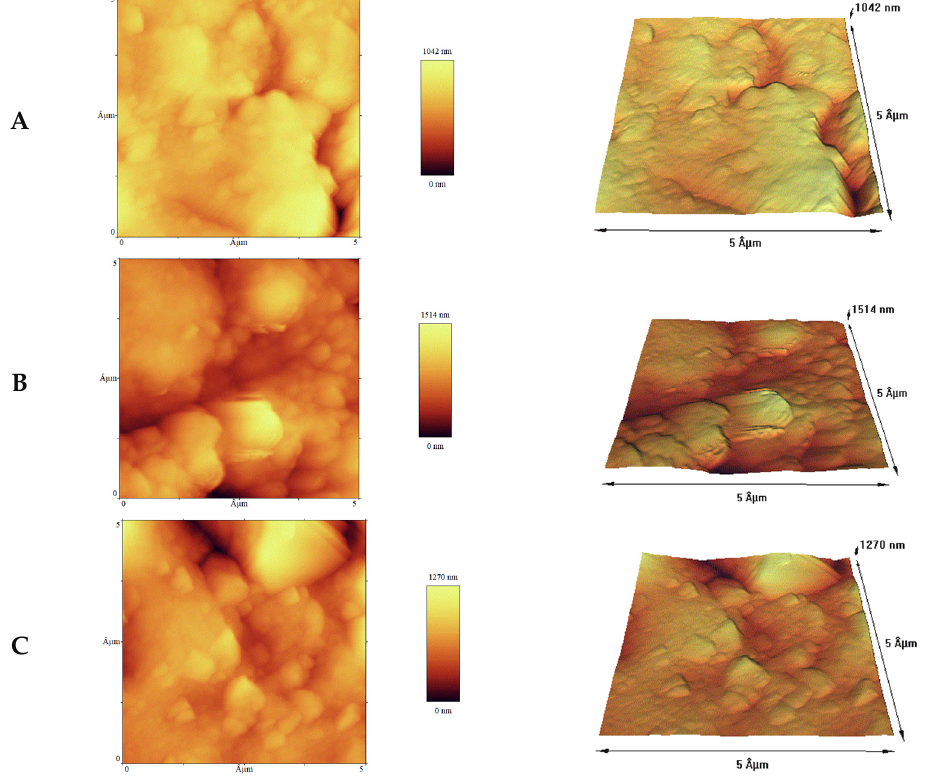
Figure 6. The roughness of membrane surface M ( A ), M/SiC ( B ), M/SiC/Fe20 ( C ).